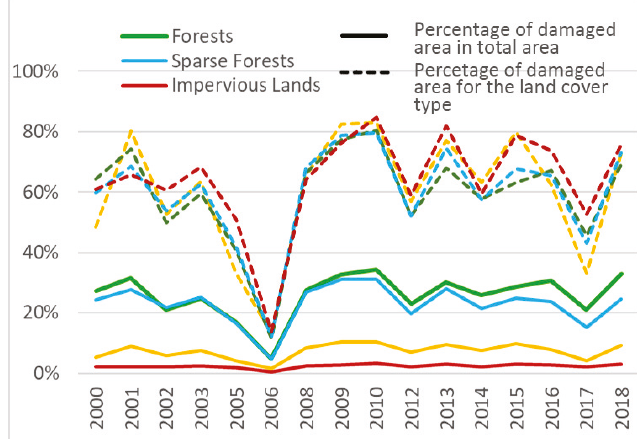
Figure 7. The percentages of damaged areas over the four dominant land cover types and the percentages of damaged area for the type in SCAC from 2000 to 2018.